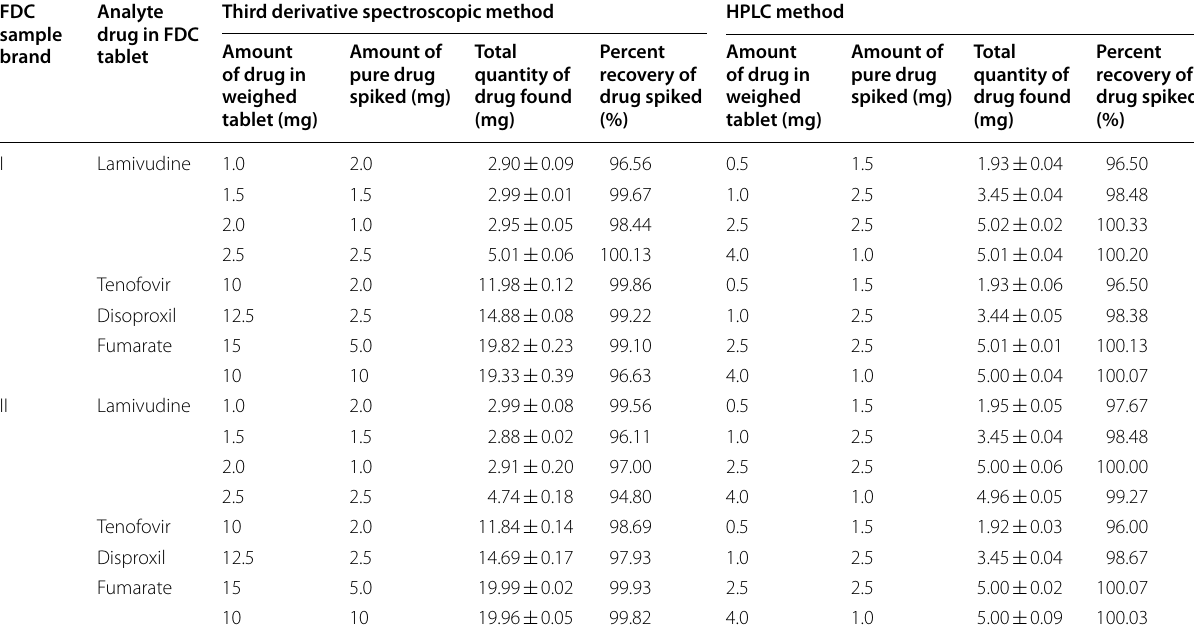
Table 4 Recovery studies for lamivudine and tenofovir disoproxil fumarate in FDC FDC